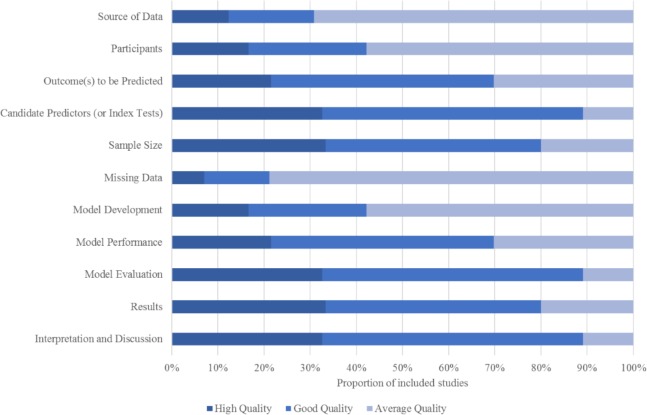
Methodological quality (% across all studies by domain).